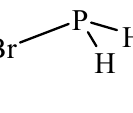
Figure 1. Computed electrostatic potential on the 0.001 au molecular surface of H 2 PBr, 1 . In ( a ), the bromine is in the foreground, to the left. In ( b ), it is in the rear, to the left. Color ranges, in kcal/mol: red, greater than 16; yellow, between 16 and 8; green, between 8 and 0; blue, less than 0 (negative). The black hemispheres show the locations of the most positive potentials, the V S,max . In ( a ) is shown the V S,max on the bromine and one of the three on the phosphorus; In ( b ) are shown the other two V S,max on the phosphorus. The hydrogens do not have separate V S,max in this molecule.